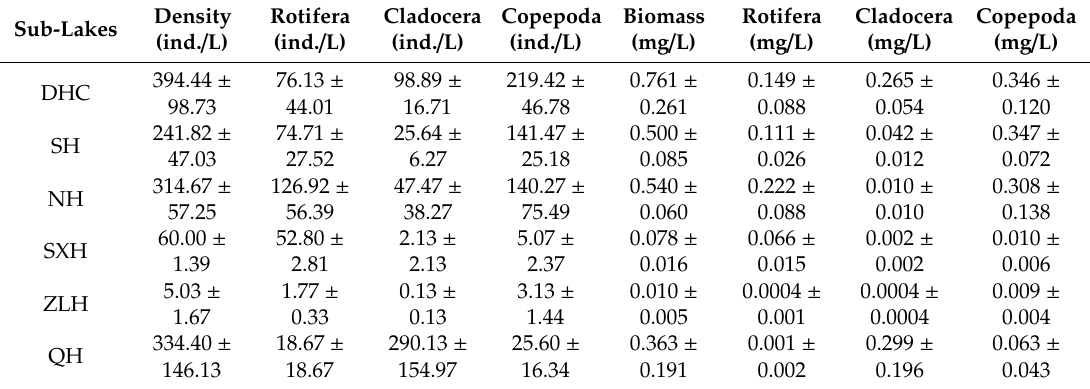
Table 2. Biomass and density of zooplankton. Biomass and density of total zooplankton, Cladocera, Copepoda and Rotifera are calculated in DHC, SH, NH, SXH ZLH and QH. Mean ±